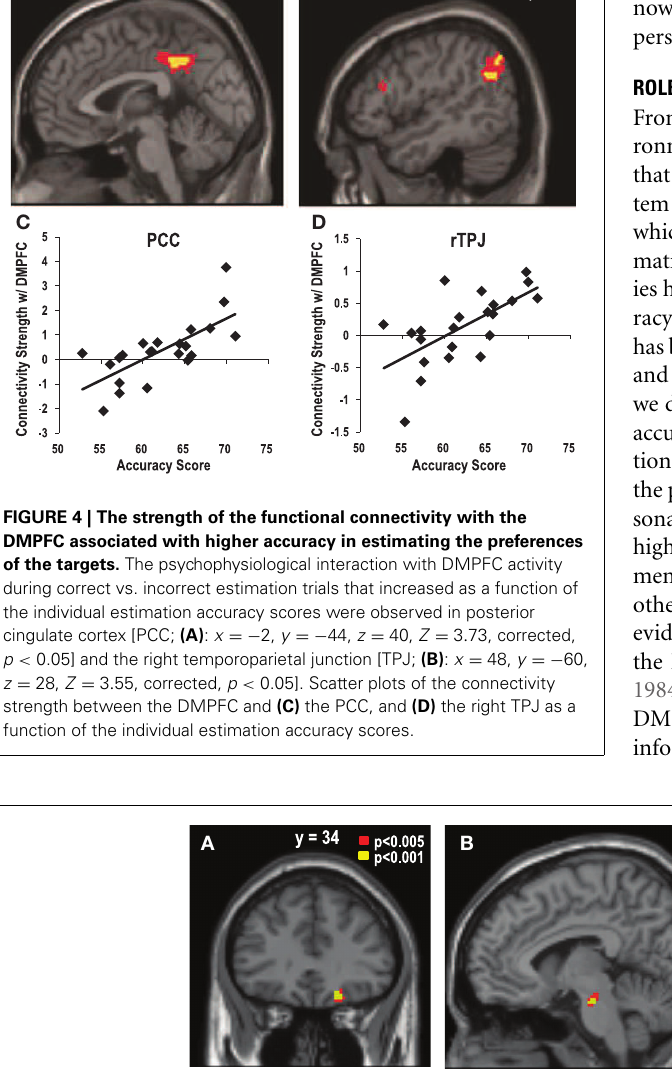
the target vs. self conditions showed positive correlations with the individual variabilities in the degree of the impact of self-preference (SP) on the estimated target preference (eTP). (C) Scatter plot of the beta estimates of the VMPFC in the contrast of the self- vs. target-trials as a function of the impact of SP on